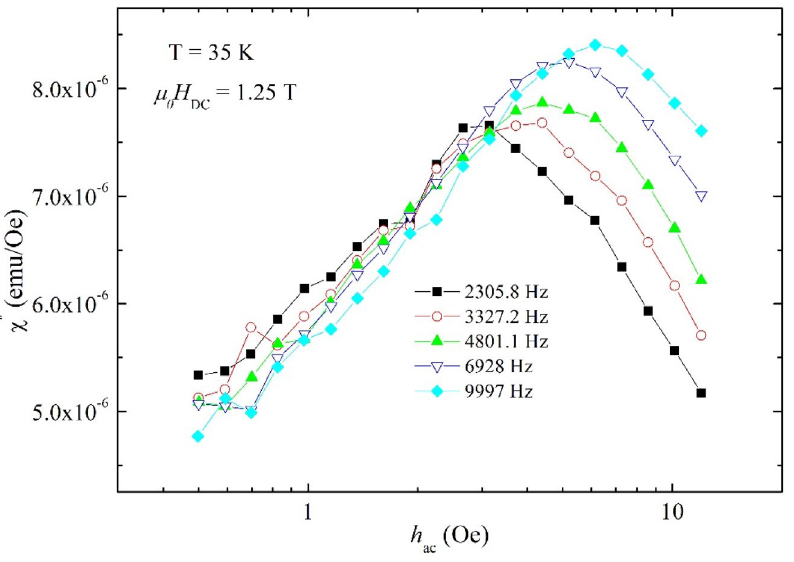
Figure 5. Dependence of the out-of-phase susceptibility on the AC field amplitude, at 35 K and in DC field of 1.25 T, for various AC field frequencies, as indicated in the